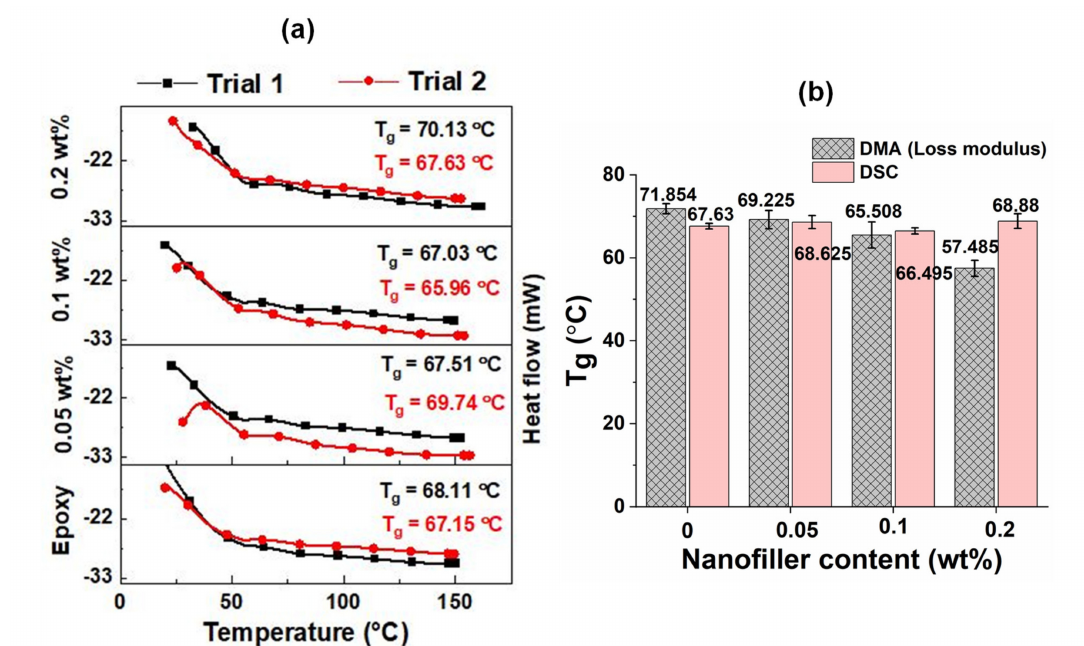
Figure 13. ( a ) DSC curves for pristine epoxy and different GO samples and ( b ) comparison of T g values measured using DMA and DSC.